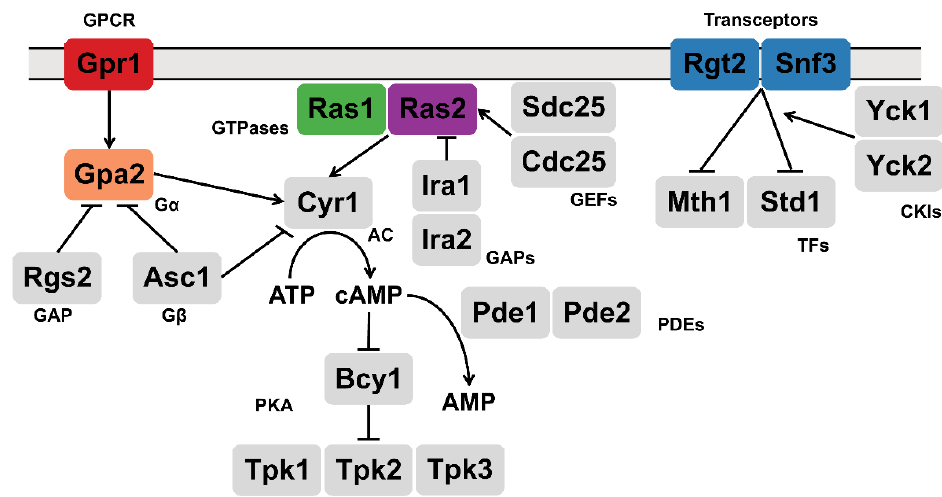
Figure 1. Glucose-sensing pathways in yeast. Two receptor pathways in S. cerevisiae respond to glucose availability. Gpr1 transmits its signal through the large G-protein Gpa2 [5–7,9–11] while Cdc25 and Sdc25 activate the small G-proteins Ras1 and Ras2. The transceptors Snf3 and Rgt2 recruit the protein kinases Yck1 and Yck2 as well as the transcription corepressors Mth1 and Std1 [45–49]. GPCR: G-protein coupled receptor; GAP: GTPase activating protein; GEF: guanine nucleotide exchange factor; AC: adenylyl cyclase; PDE: phosphodiesterase; TF: transcription factor; CKI: casein kinase I; PKA: protein kinase A. The second glucose-sensing system consists of the cell surface proteins Snf3 and Rgt2.